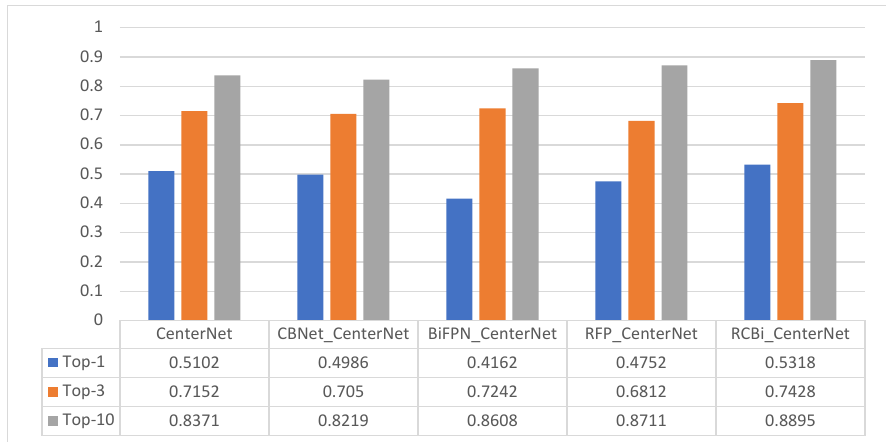
Figure 9. Performance comparison.